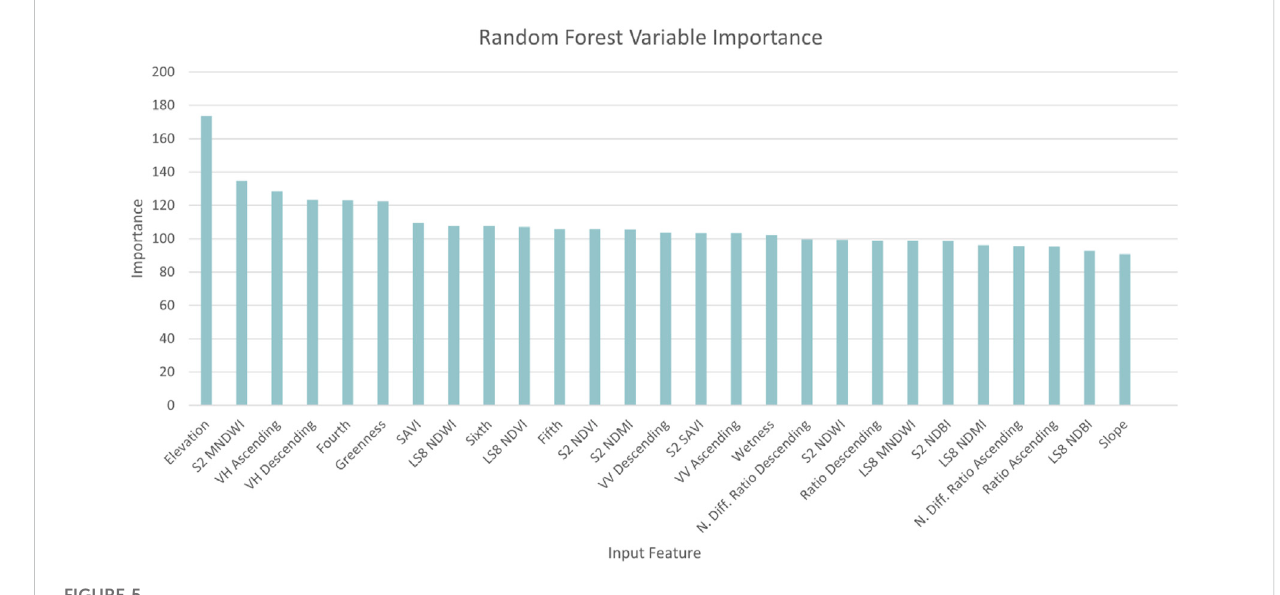
FIGURE 5 LTE2 555 model variable importance.